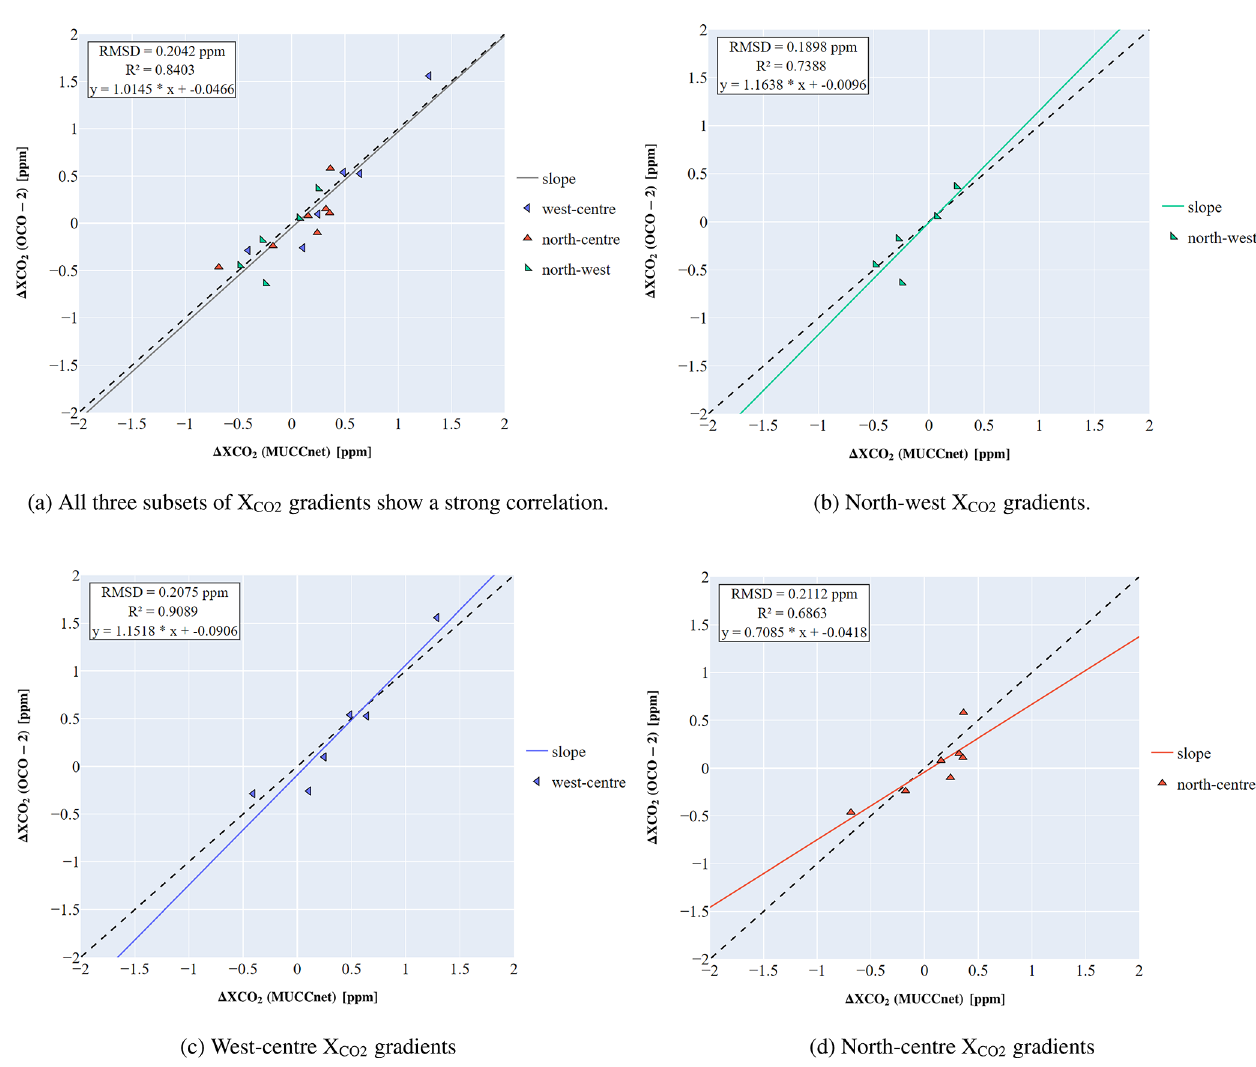
Figure B1. Linear regression results of spaceborne and ground-based X CO enhancements when gradients captured on 18 August and 2 27 June 2020 are removed from the set. When removing overpasses with a high difference in daily by-site offsets, which impedes the correct detection of urban gradients, we obtain a strong to very strong correlation between OCO-2 and MUCCnet gradients.